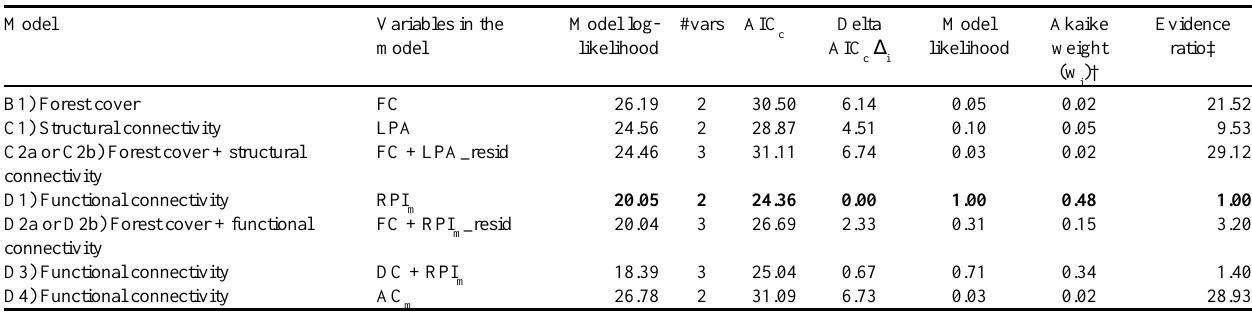
Table 5 . Model selection for S. citrina nest occurrence in 2005 (southern Ontario) with standardized site-context measures of forest cover, and structural OR graph-based functional connectivity. Variable codes and transformations as in Table 1. Further model details, e.g., parameter estimates, standard errors, odds ratios, can be found in Table 4. Model